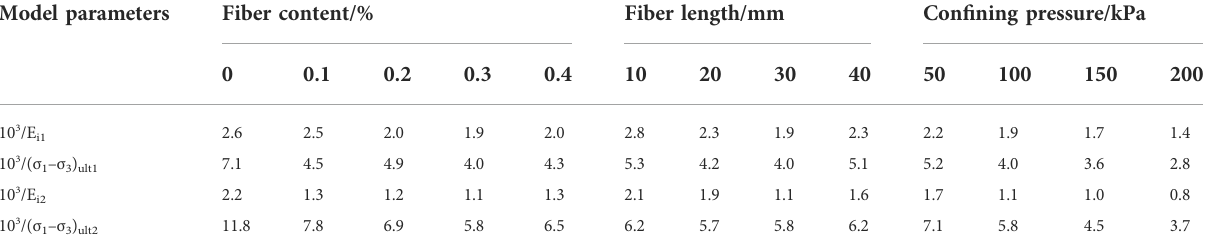
TABLE 3 Stress-strain calculation parameters of coir fi ber-reinforced soil. Model parameters